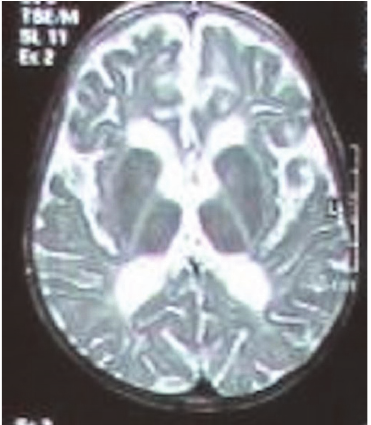
Figure 2: Brain MRI of the patient shows cerebral atrophy. Note hypomyelination and leukodystrophy.